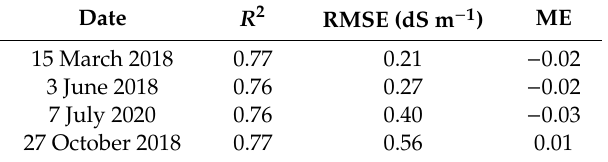
Table 6. Independent cross-validated results of 3D-IDW interpolation at di ff erent